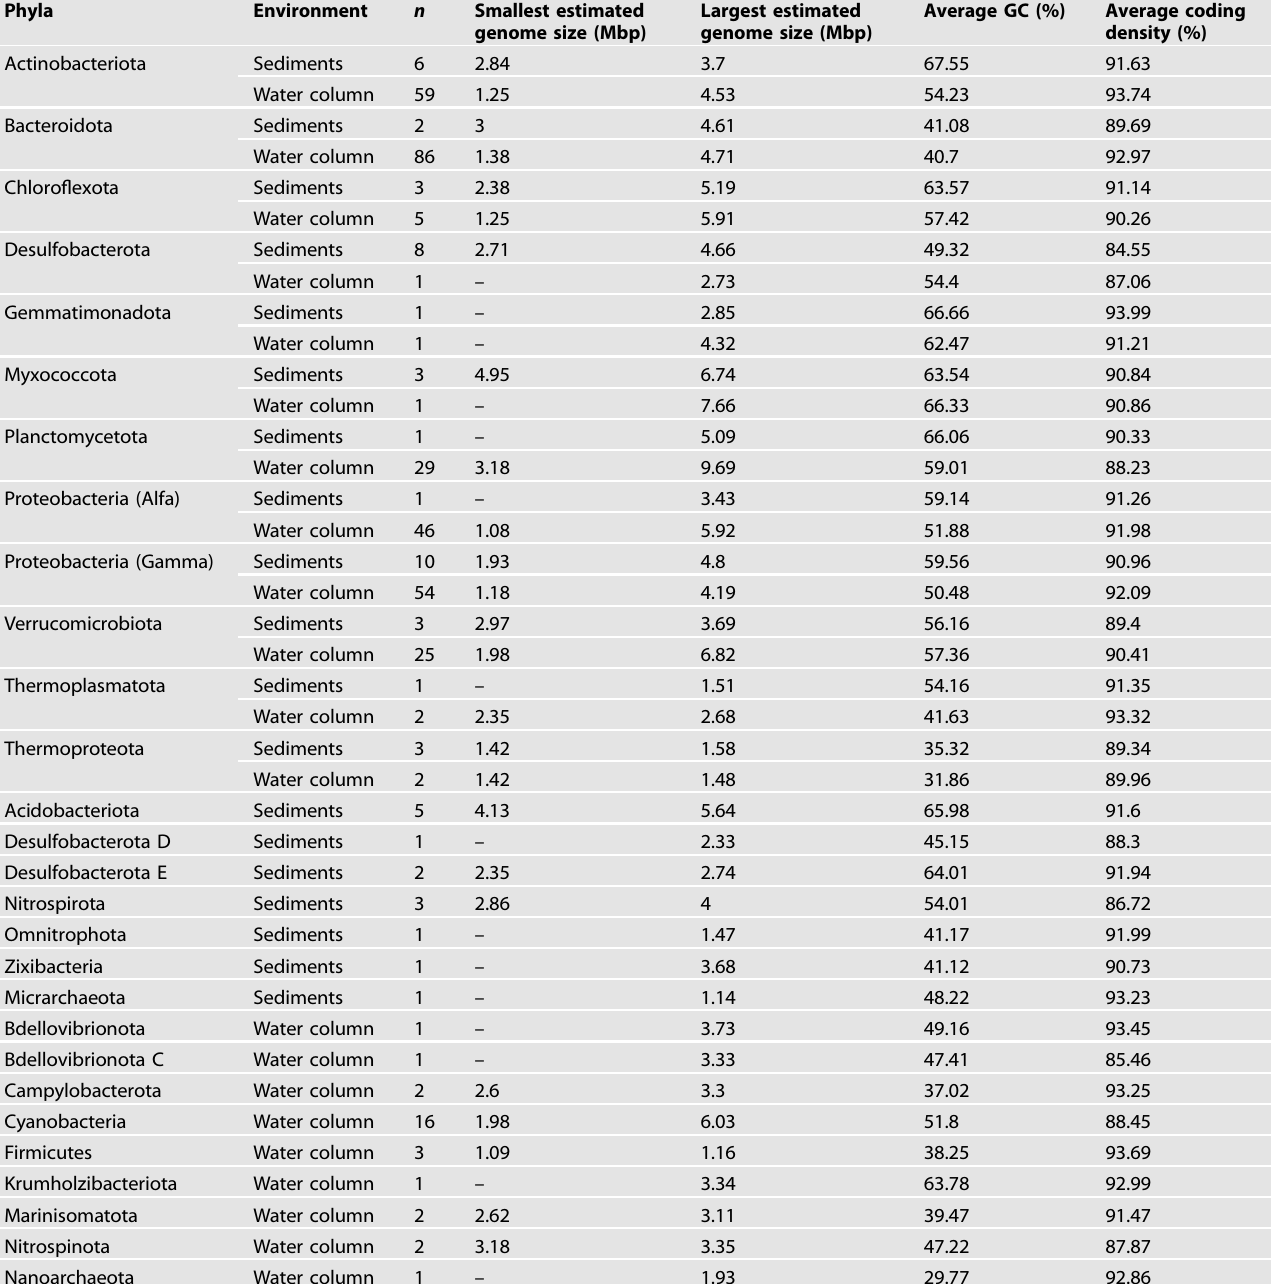
Table 1. Summary of all 56 sediment and 340 water column representative MAGs (95% average nucleotide identity) with >75%